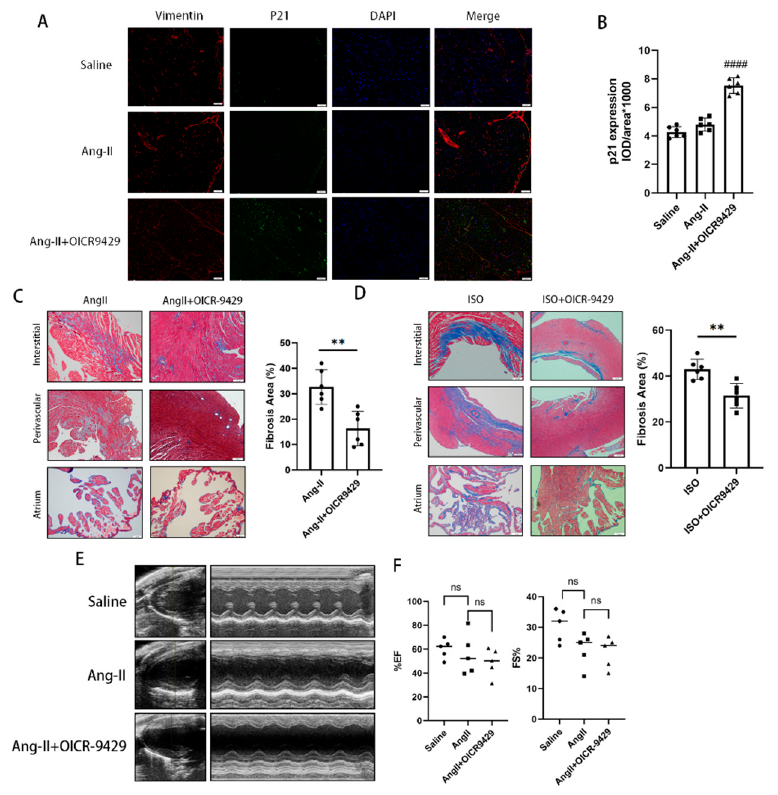
Figure 7. Pharmacologic inhibition of Wdr5 by OICR-9429 induced selective fibroblast senescence and attenuated the Ang-II-induced fibrosis. ( A ) Representative fluorescent images of P21, vimentin (a marker of fibroblasts), and DAPI in heart after treatment of OICR9429 and Ang II (Scale bar 50 µm). ( B ) is the quantitative analysis of graph ( A ). ( C , D ) Masson’s trichrome staining showed attenuated fibrosis by treatment of OICR-9429 in the models of Ang II or ISO in different areas. ( E , F ) OICR9429 did not affect the ventricular systolic function by measuring EF and FS. Data are presented as mean ± SEM. Scale bar 100 µm. ** p < 0.01, #### p < 0.0001 vs. Ang-II group .